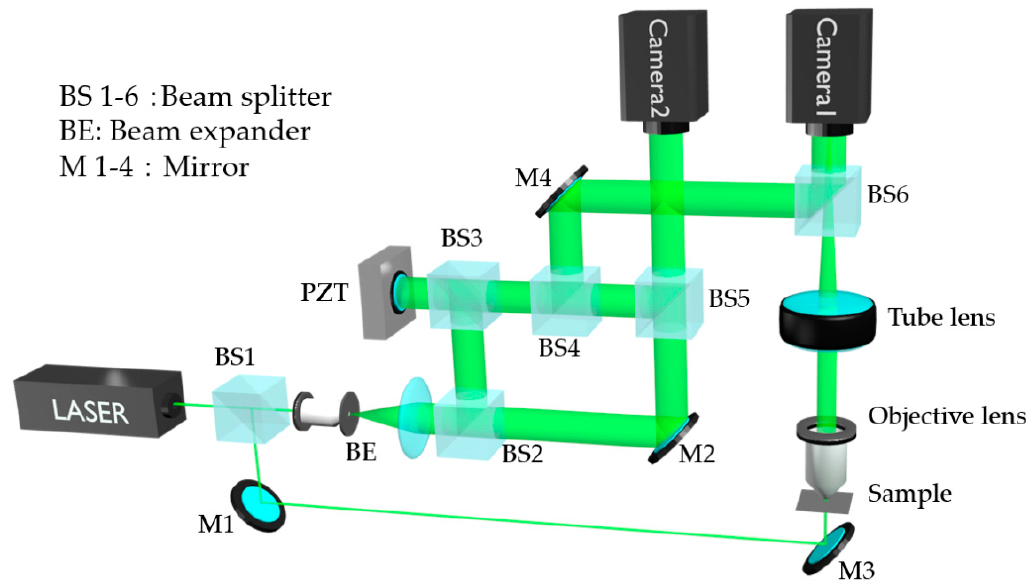
Figure 1. The sketch of the proposed calibrated phase-shifting digital holographic microscope system.